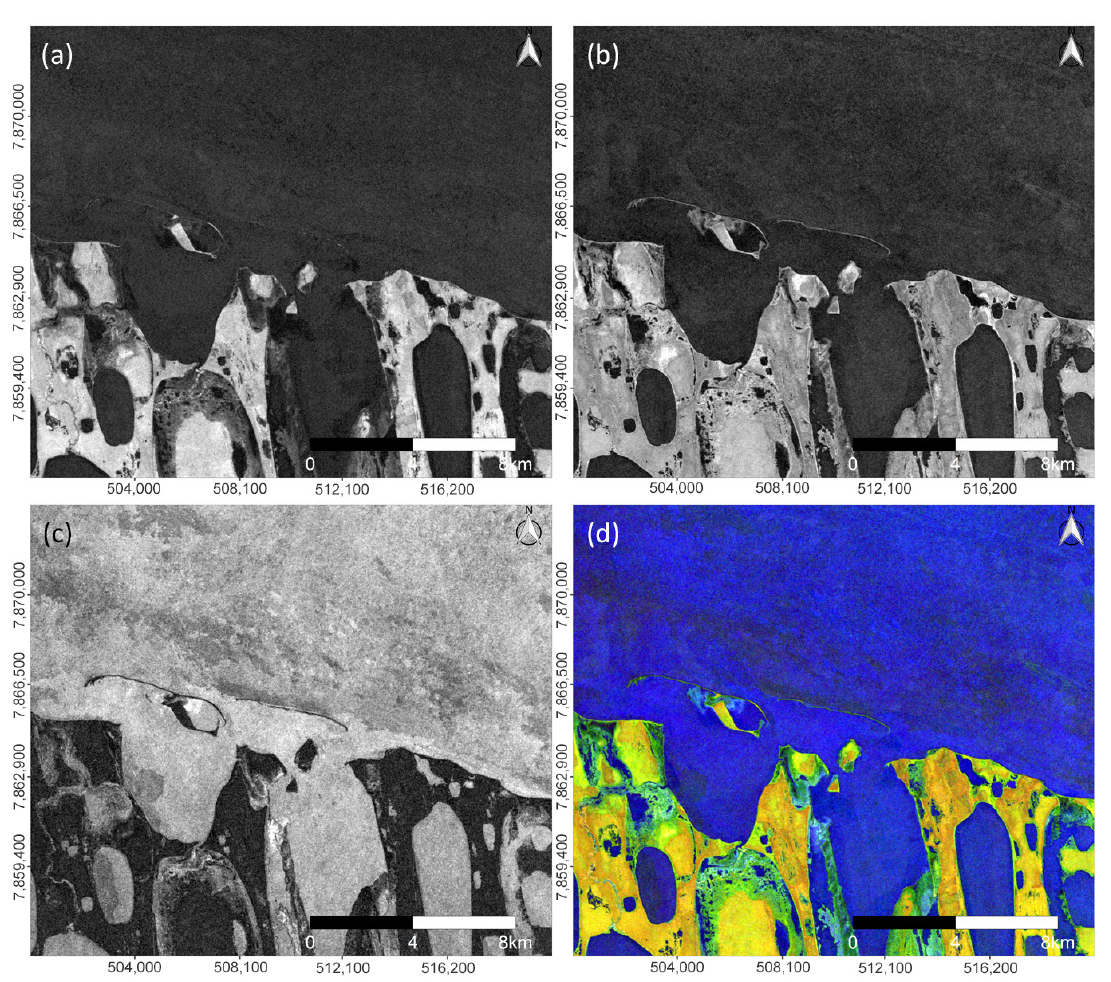
Figure 4. Subsection of the study area Cape Halkett in the United States of America (USA) (aoi 02) visualized by ( a ) annual median VH backscatter, ( b ) annual median VV backscatter, ( c ) annual sd VV backscatter, and ( d ) a pseudo-RGB composite of ( a – c ) based on S1 GRD scenes from June